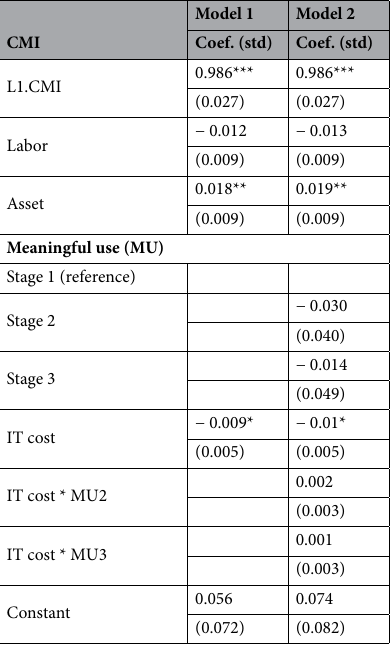
Table 3. DPD regression results: a sample of 2,135 pooled observations representing 309 unique acute care hospitals in California operating between 2009 and 2015. *p < 0.1, **p < 0.05; ***p <